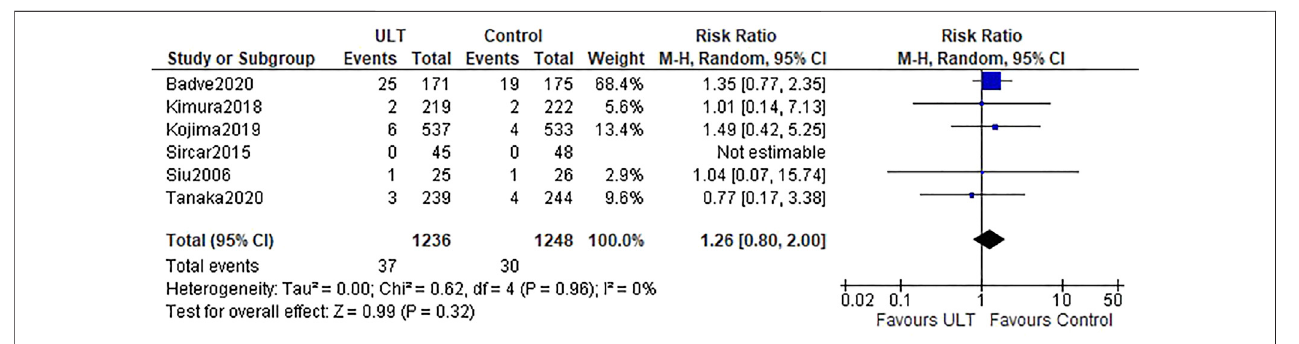
FIGURE 3 | Kidney events: ULT vs control